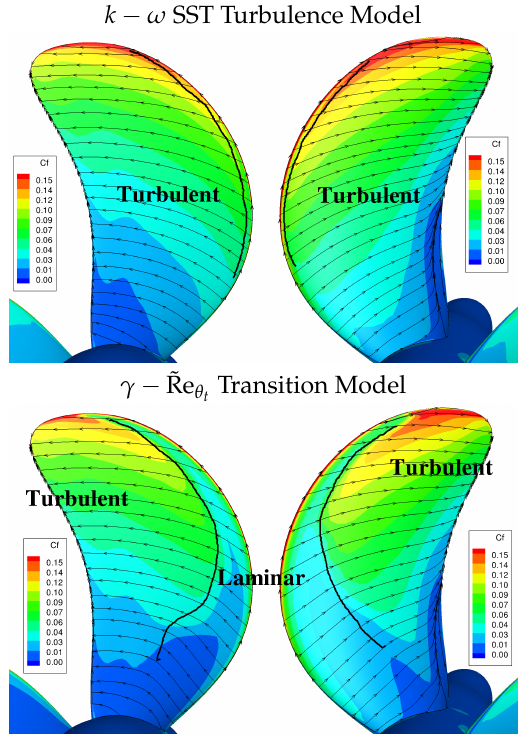
Figure 18. Limiting streamlines and skin friction coefficient using the k − ω SST turbulence model ( top ) and γ − ˜Re θ transition model ( bottom ) at Re = 1 × 10 6 for J = 0.568. Pressure side ( left ) and t suction side ( right